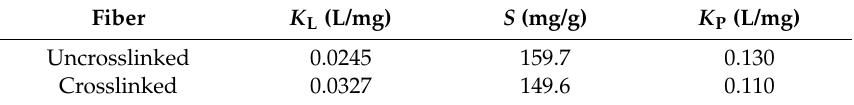
Table 2. Parameters in the Langmuir–Nernst equation for the adsorption of lac dye on chitosan fibers.